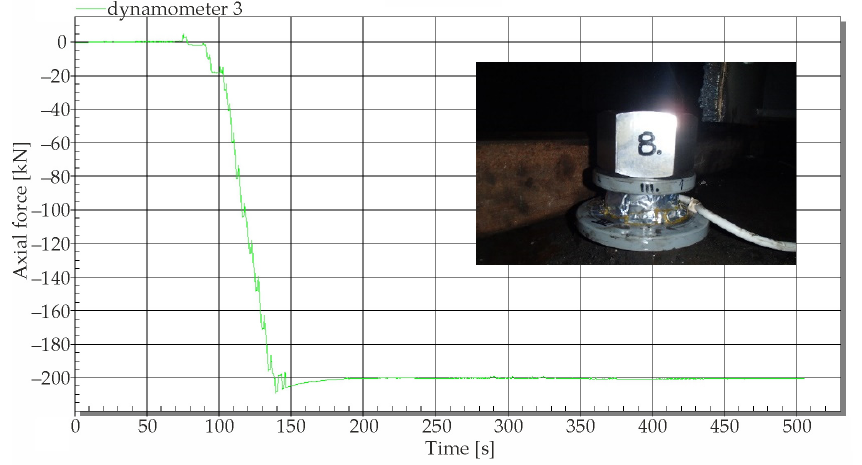
Figure 8. Tightening nut No. 8 according to the required preload of 200 kN registered by Dynamometer